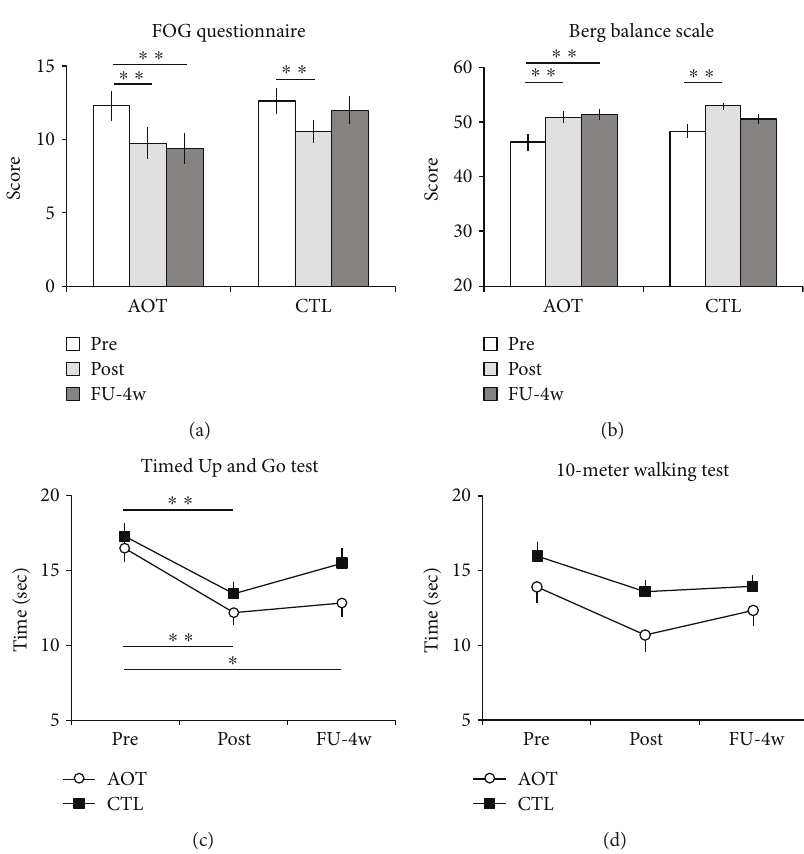
Figure 1: (a-b) FoG-Q and BBS mean scores ( ± SE). (c-d) TUG and 10M-WT mean times ( ± SE). Baseline (PRE), end of training (POST), and 4-weeks follow-up (FU-4w) results are shown. Asterisks indicate when statistical signi fi cant di ff erences within testing time evaluations emerged at post hoc analysis when the interaction term GROUP X TIME was signi fi cant ( ∗ p < 0 05 ; ∗∗ p < 0 001 ). AOT: action observation training arm; LOT: landscape observation training arm; FoG-Q: new freezing of gait questionnaire; BBS: Berg balance scale; 10M-WT: 10-meter walking test; TUG: Timed Up and